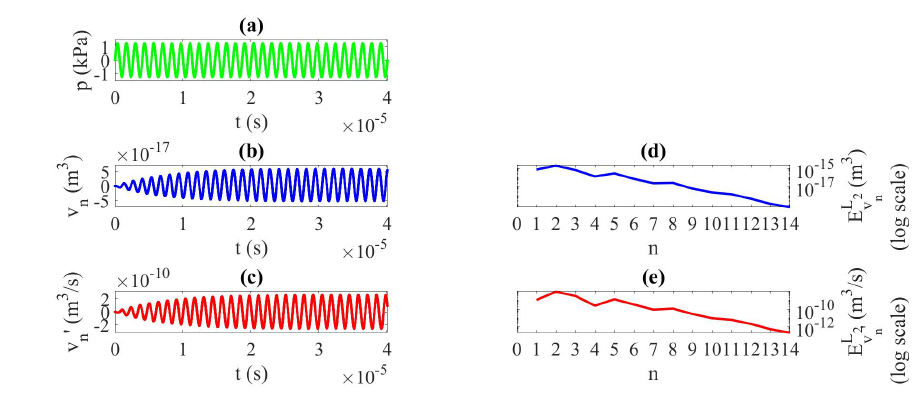
Figure 2. Case 1. f = f b , high finite amplitude with nonlinear terms. ( a ) Pressure source signal, ( b ) bubble-volume variation, ( c ) speed of bubble-volume variation; last iteration n = N . L 2 -norm error at each iteration n of the calculation; ( d ) v n , ( e ) v (cid:48) n